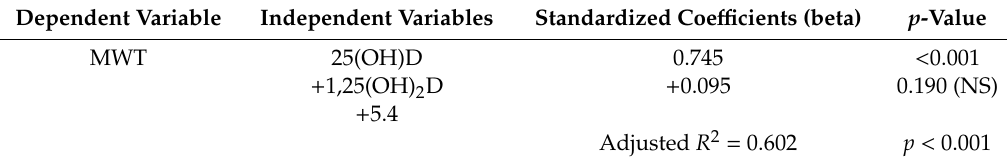
Table 3. Multiple linear regression analyses for biochemical determinants of Mean Wall